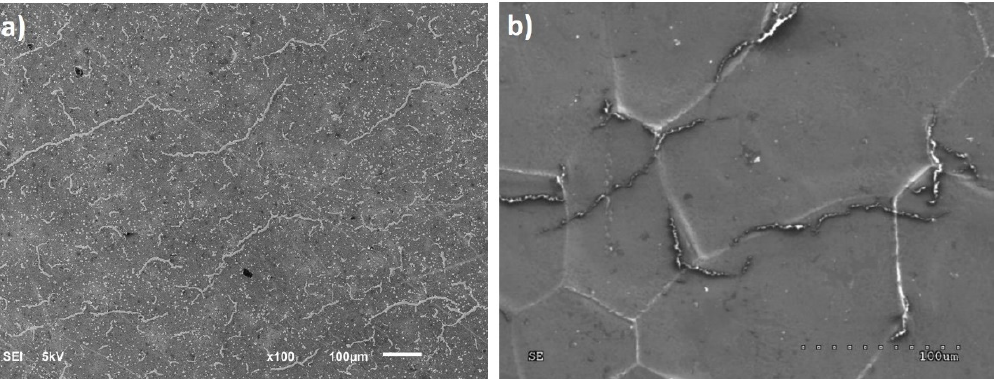
Figure 1. SEM image of graphene: ( a ) transferred to a SiO 2 substrate after chemical etching, ( b ) on PMMA after hydrogen delamination.